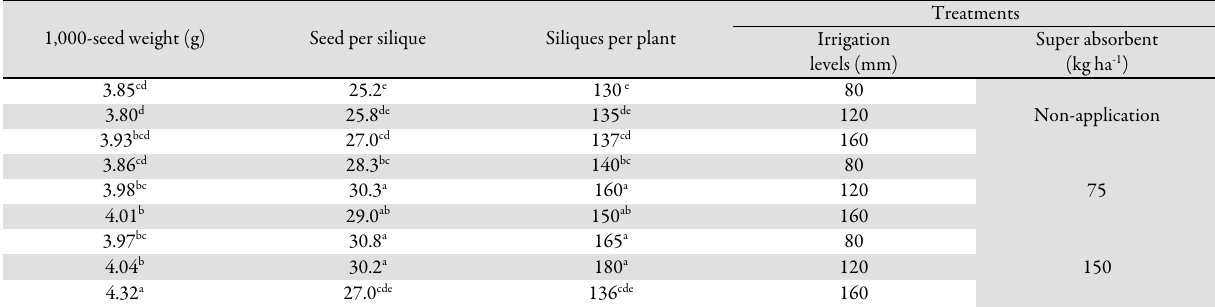
Table 3. Siliques number per plant, seed number per silique and 1,000-seed weight as influenced by super absorbent rate and irrigation